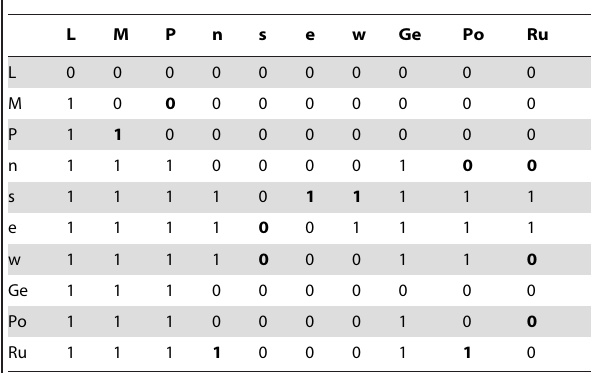
Table 2. Ordinal relation of similarity differences represented as a connection matrix C B London for London relative to the set of words { London, Moscow, Paris, north, south, east, west, Germany, Poland, Russia } shown by initial letters, derived from the probability density estimates for the brain data in Figure 9.